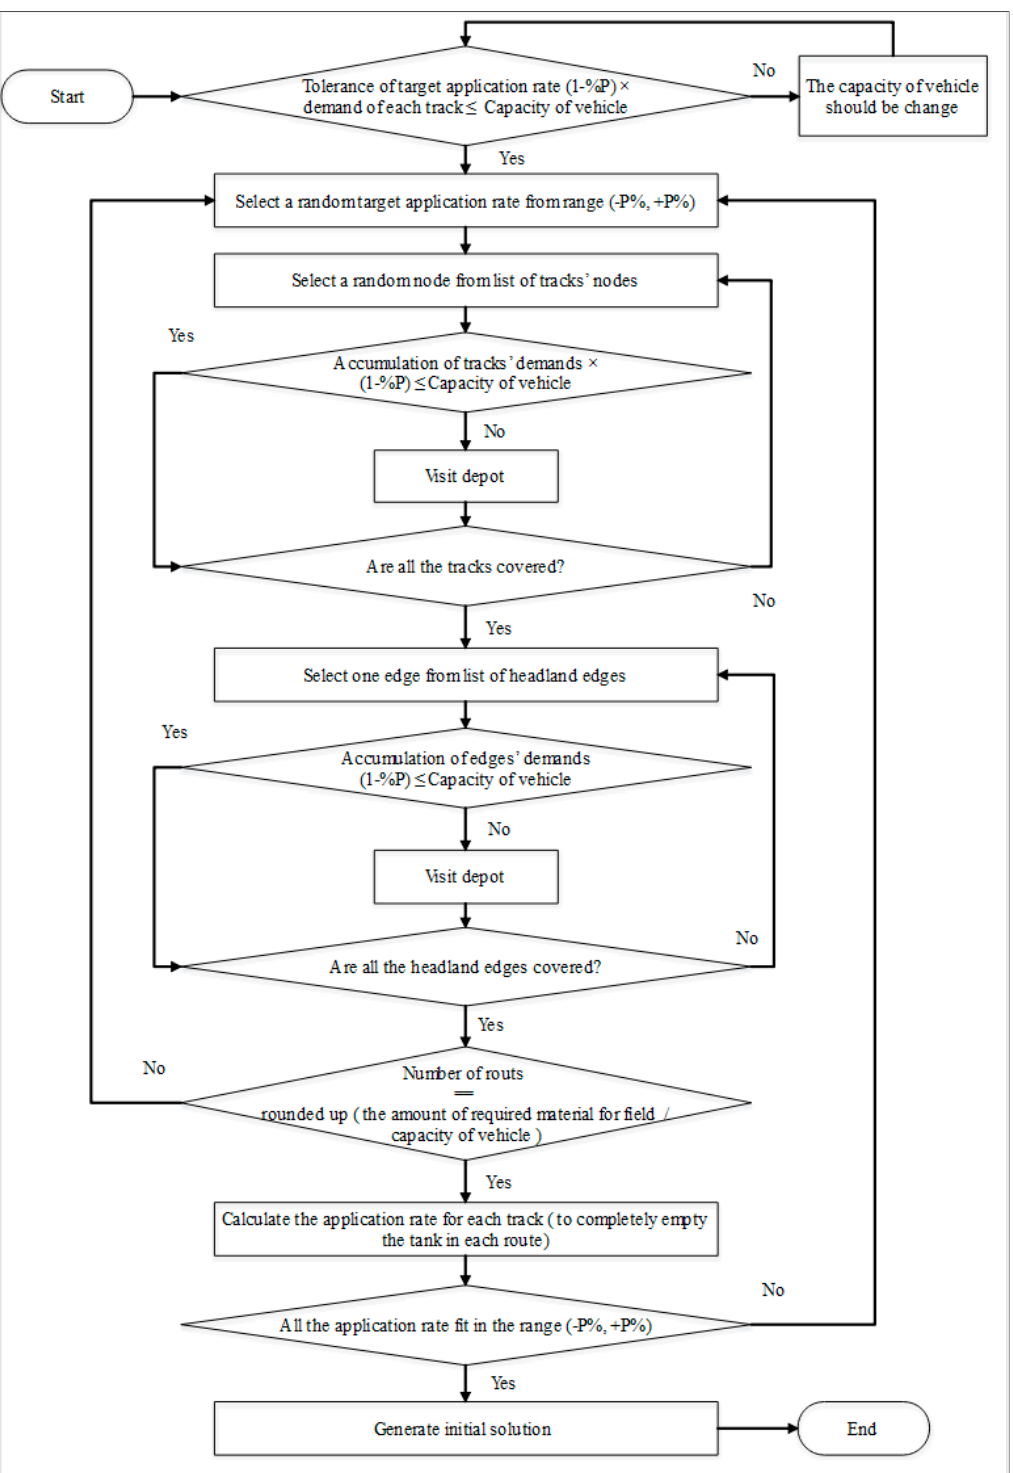
Figure 4. The overview of the process of generating an initial solution.